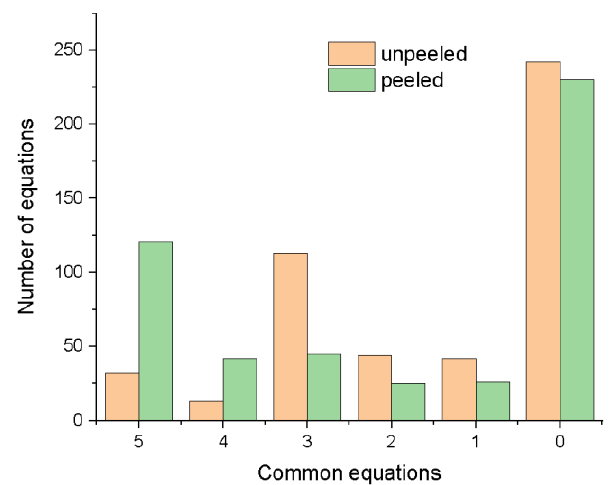
Figure 13. The number of common equations is represented graphically.